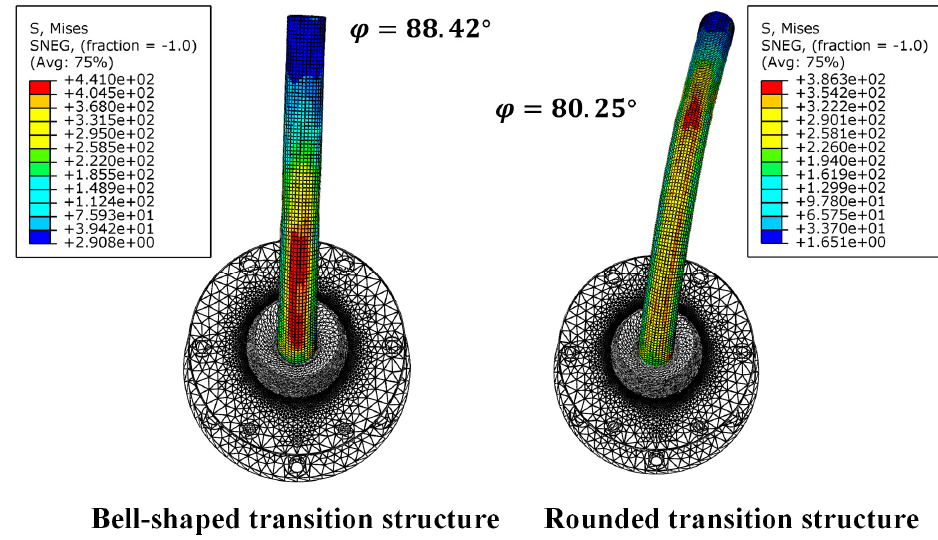
Figure 12. Simulation results based on different transition structures.